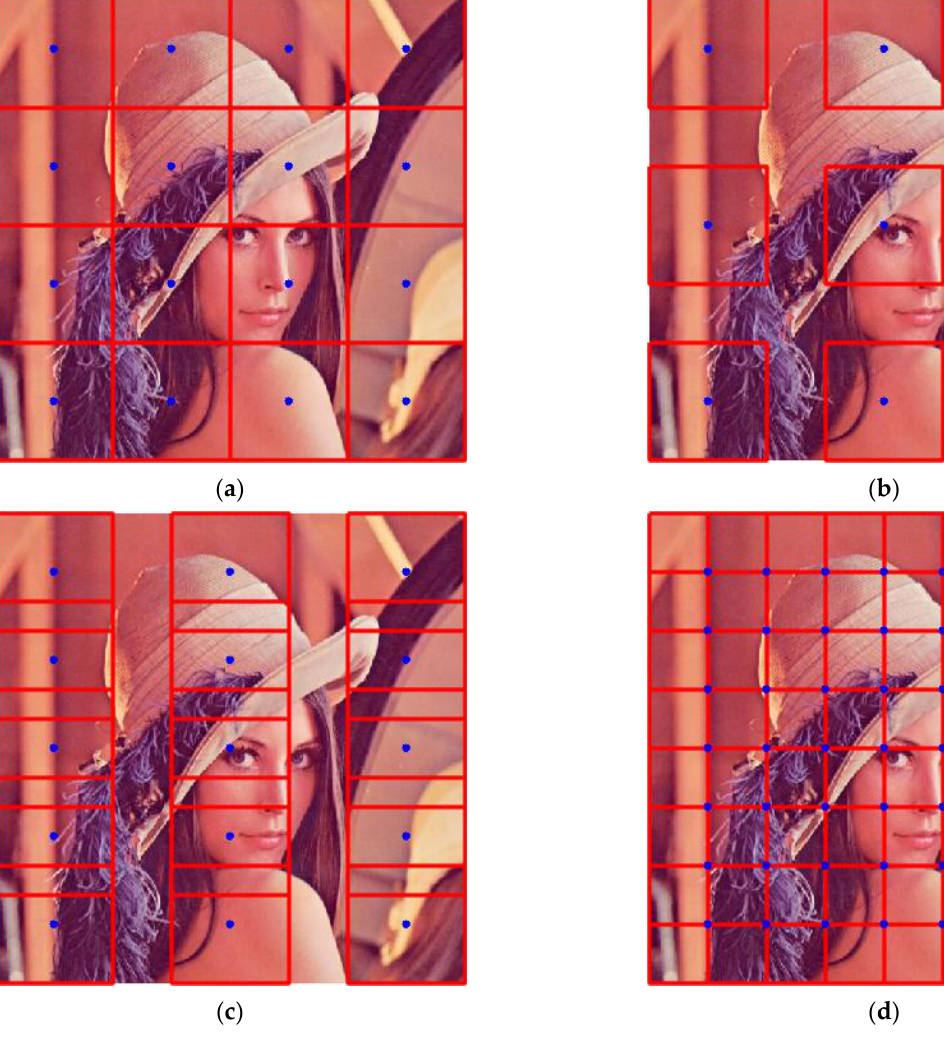
Figure 2. Examples of controlling the offset between patches using the Stride parameter: ( a ) dense, non-overlapping patches without gaps; ( b ) patches with the same gap between them in both direc- tions; ( c ) patches that overlap only in the 𝑦 direction; ( d ) patches that overlap in both directions. Image sample512.jpg has dimensions M × N = 512 × 512, and the patch size is W × H = 128 × 128. Patches are marked as red squares, and blue dots denote patch centers.